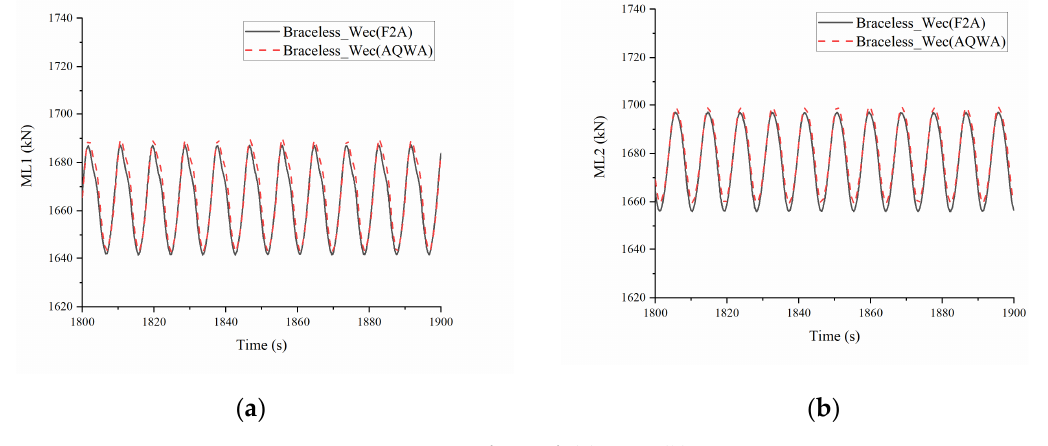
( b ) ( c ) Figure 7. Time series of different responses of the combined structure under regular waves: ( a ) Relative Heave Velocity; ( b ) Damping Force; ( c ) Produced Power.